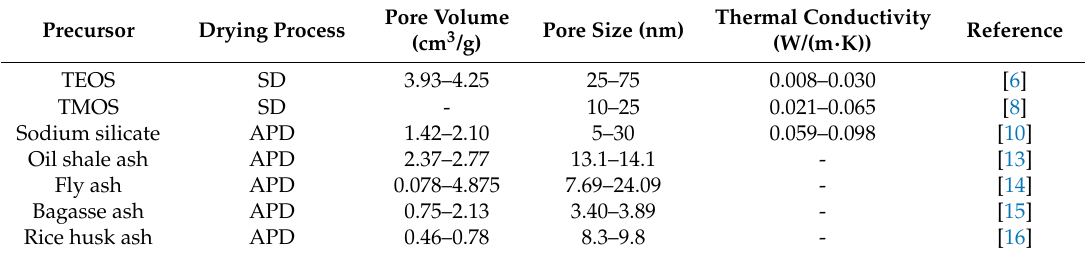
Table 1. Thermal and textual properties of silica aerogels produced from different raw materials and drying processes.